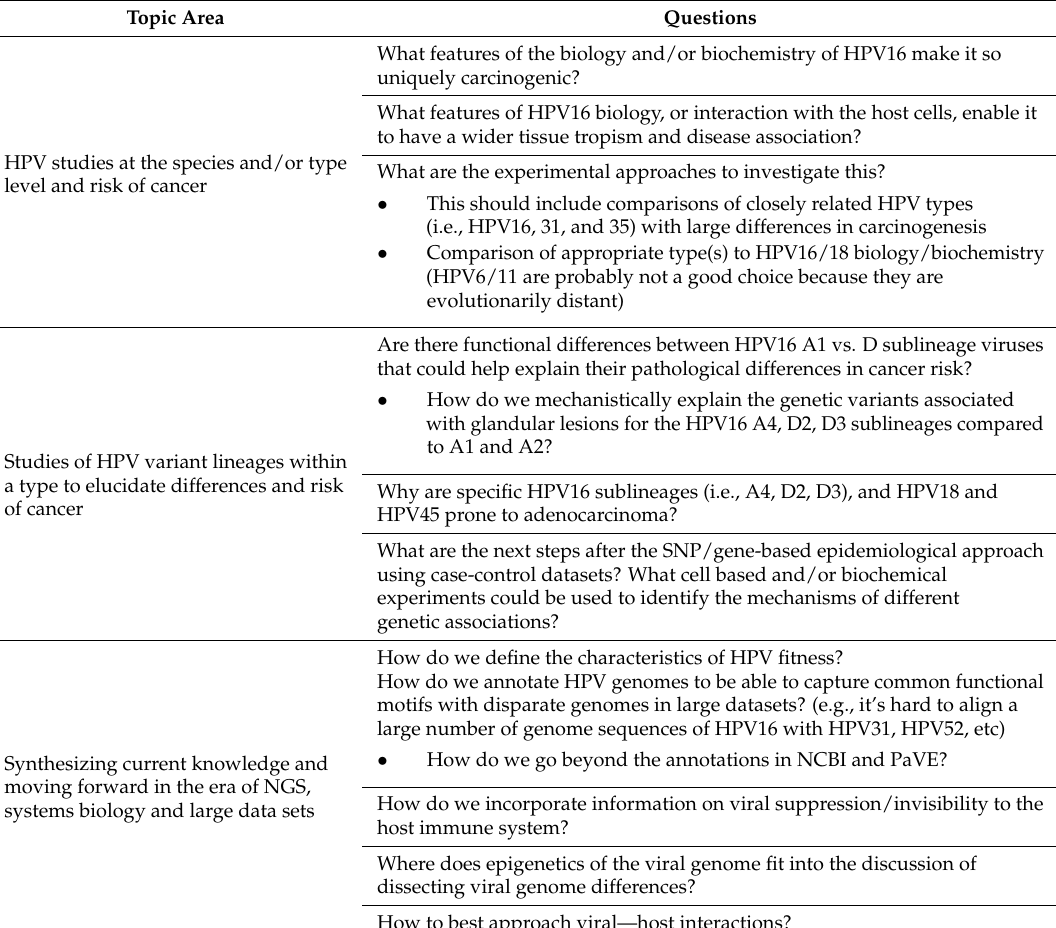
Table 1. Topics and specific questions addressed at the National Cancer Institute (NCI) HPV